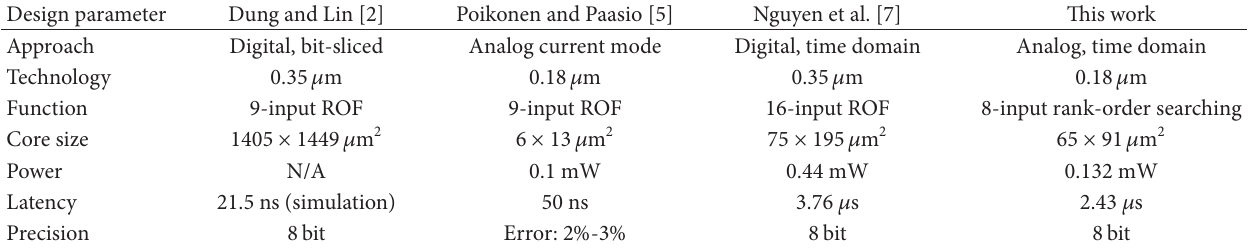
F 9: Response of the comparator. T 2: Performance comparison.